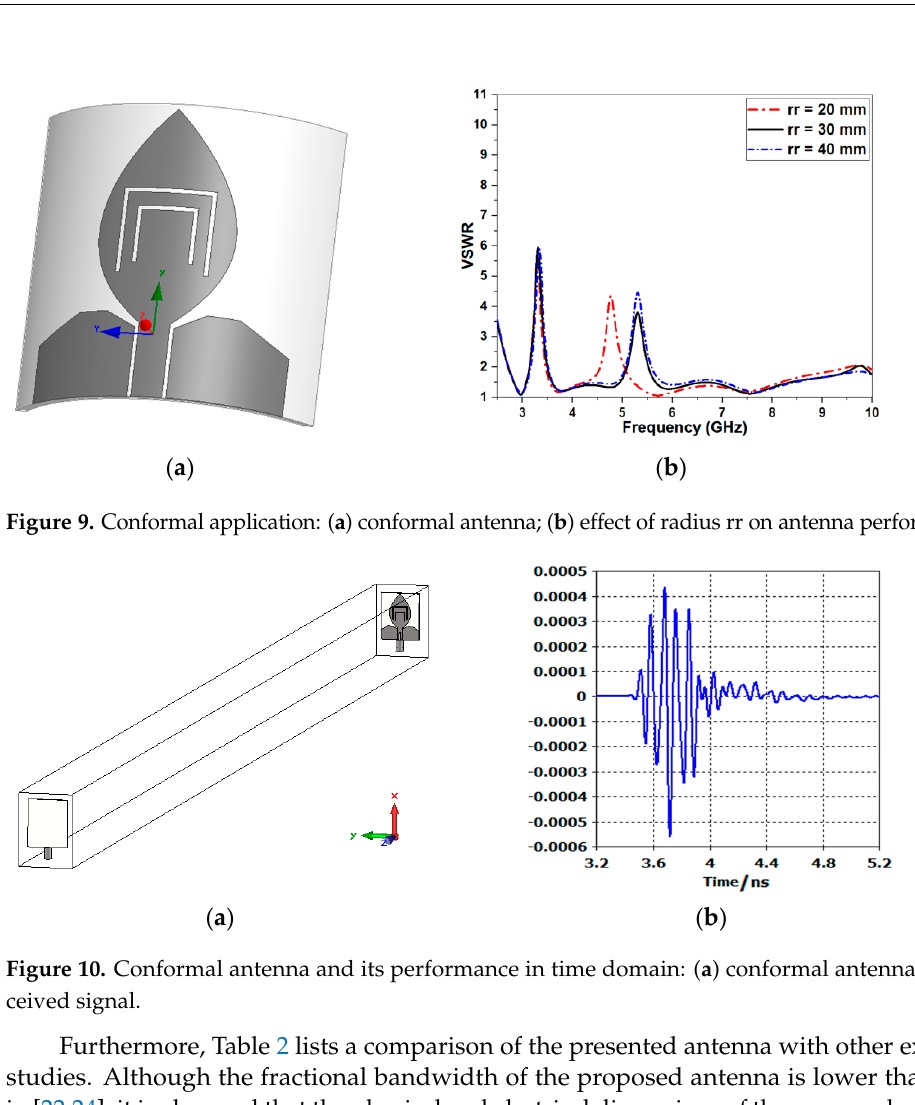
Figure 10. Conformal antenna and its performance in time domain: ( a ) conformal antenna; ( b ) re- ceived signal.